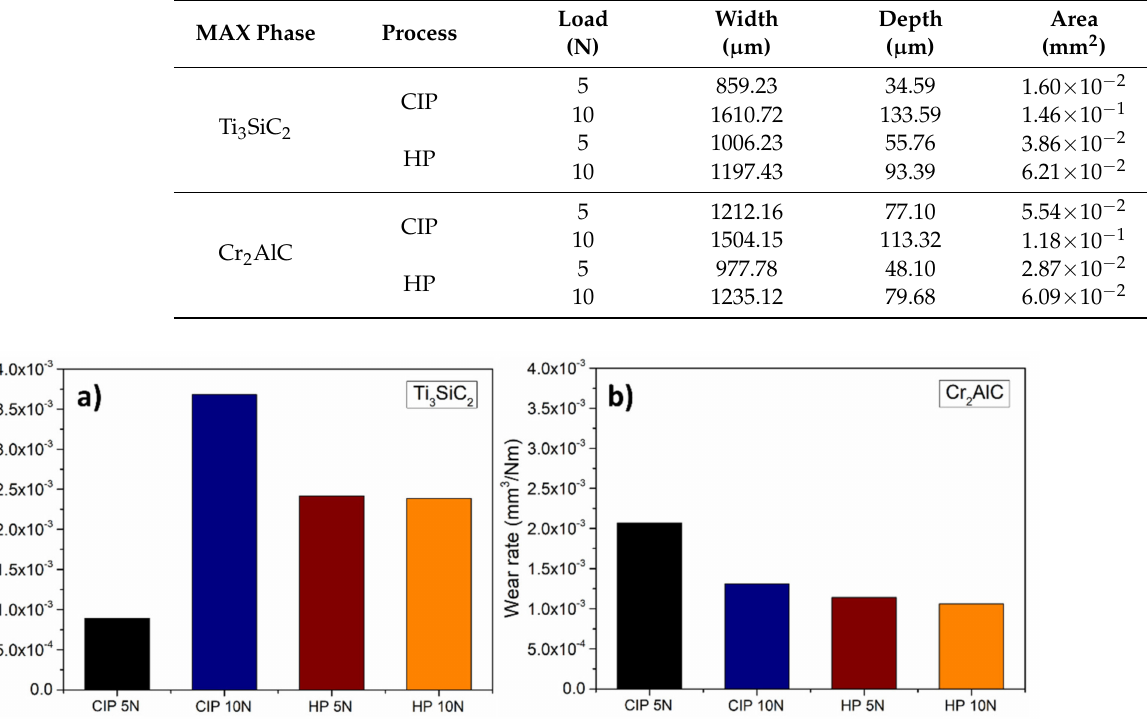
Figure 14. The wear rate calculations of samples processed by cold isostatic pressing and sintering (CIP) and hot pressing (HP) for ( a ) Ti 3 SiC 2 and ( b ) Cr 2